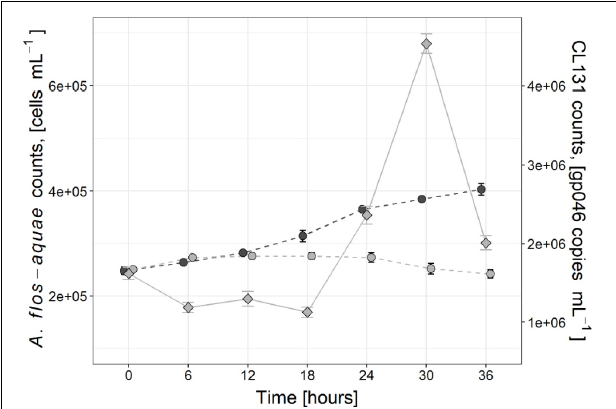
FIGURE 1 | Changes in Aphanizomenon flos-aquae strain 2012/KM1/D3 cell abundance (circles) in the control (dark gray) and infected (light gray) treatments as well as dynamics of cyanophage vB_AphaS-CL131 gp046 gene copy numbers (diamonds) during the course of incubation experiment. Symbols indicate the mean values, and the error bar shows the standard deviation of three technical